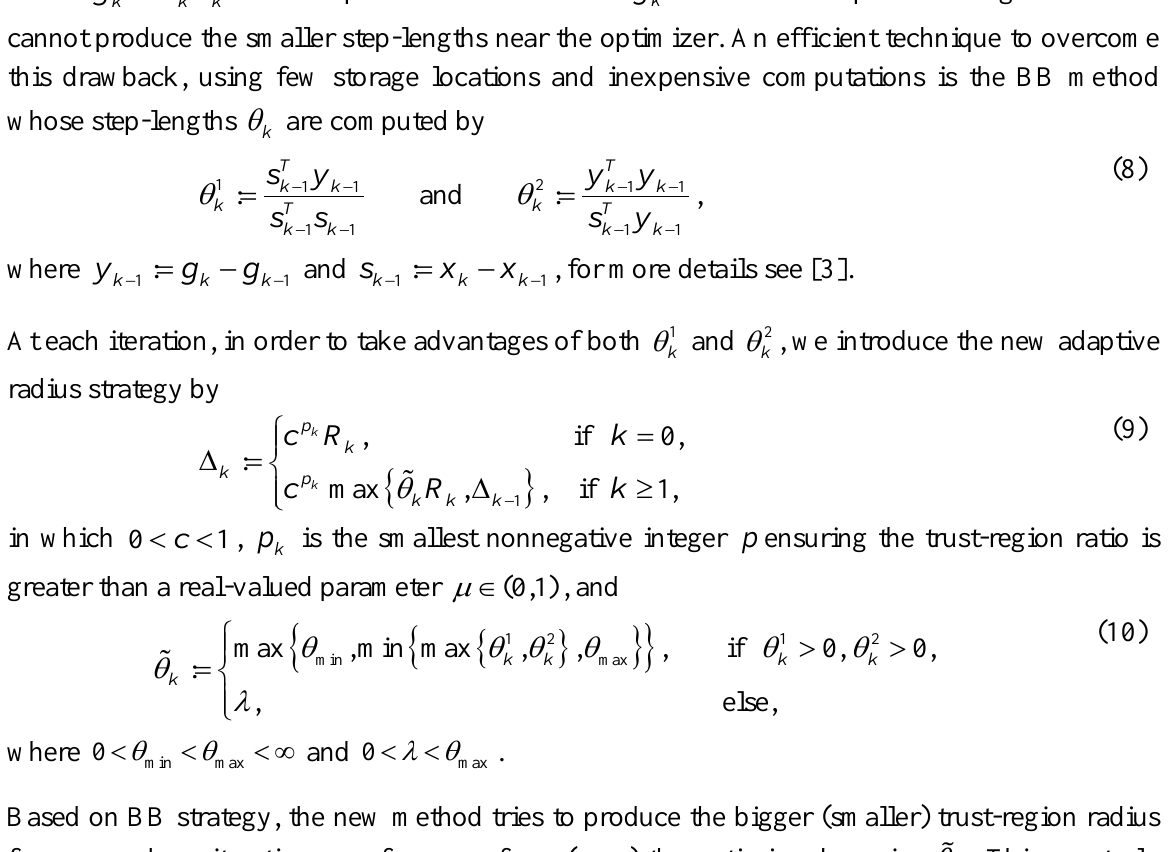
Algorithm 1. BBATR (Barzilai Borwein Adaptive Trust-Region